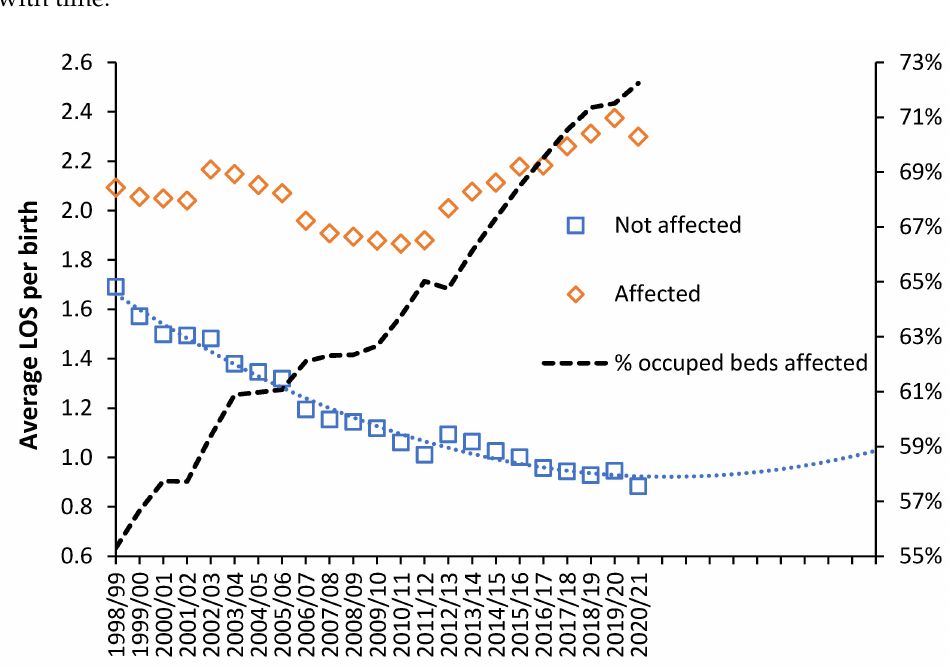
Figure A5. Trends in average length of stay for maternity admissions (ICD-10 Chapter O) for more complex pregnancy and births “affected” versus less complex pregnancy and births “not affected” from 1998/99 to 2020/21. Data is from NHS Digital [69]. The trend line for the “affected” group is a second order